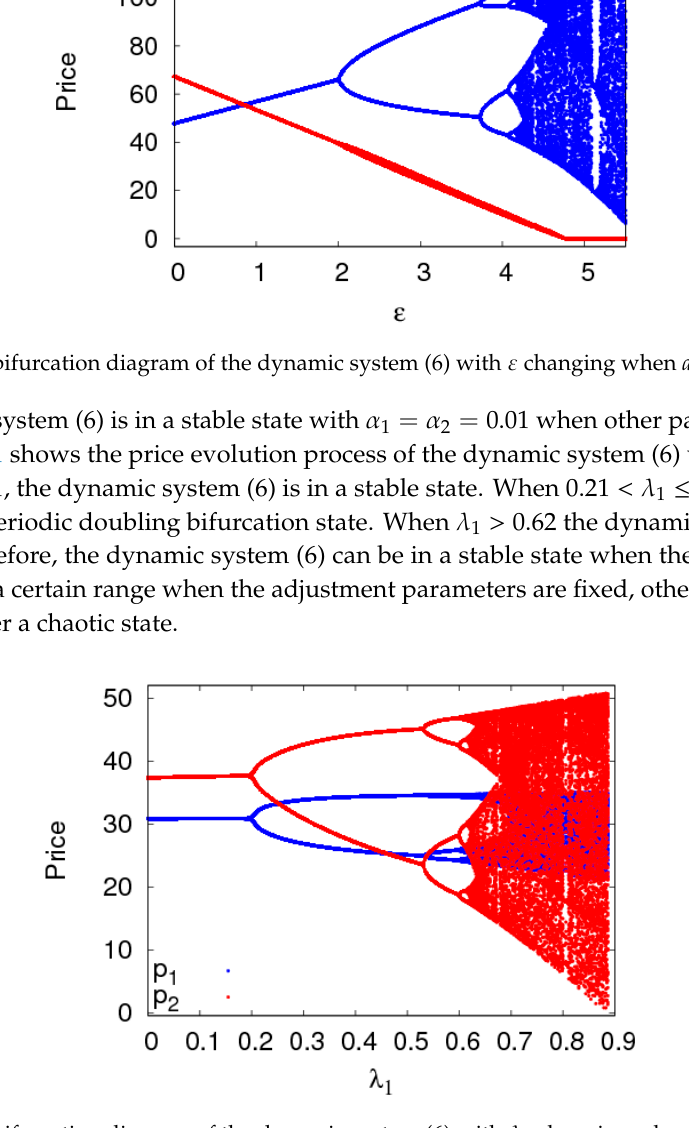
Figure 11. The bifurcation diagram of the dynamic system (6) with λ 1 changing when a 1 = 0.01, a 2 = 0.01 .